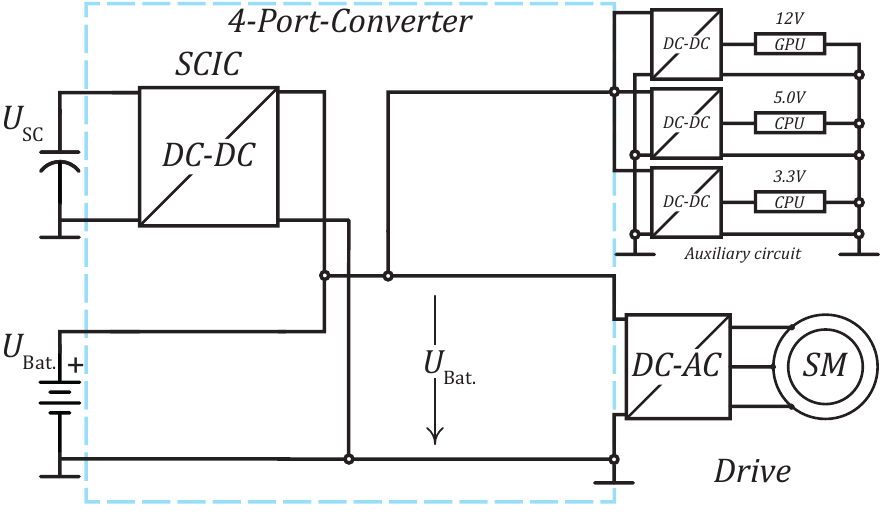
Figure 9. Topology V: Extension of the Classic solution with a super-capacitor module and an interface converter.